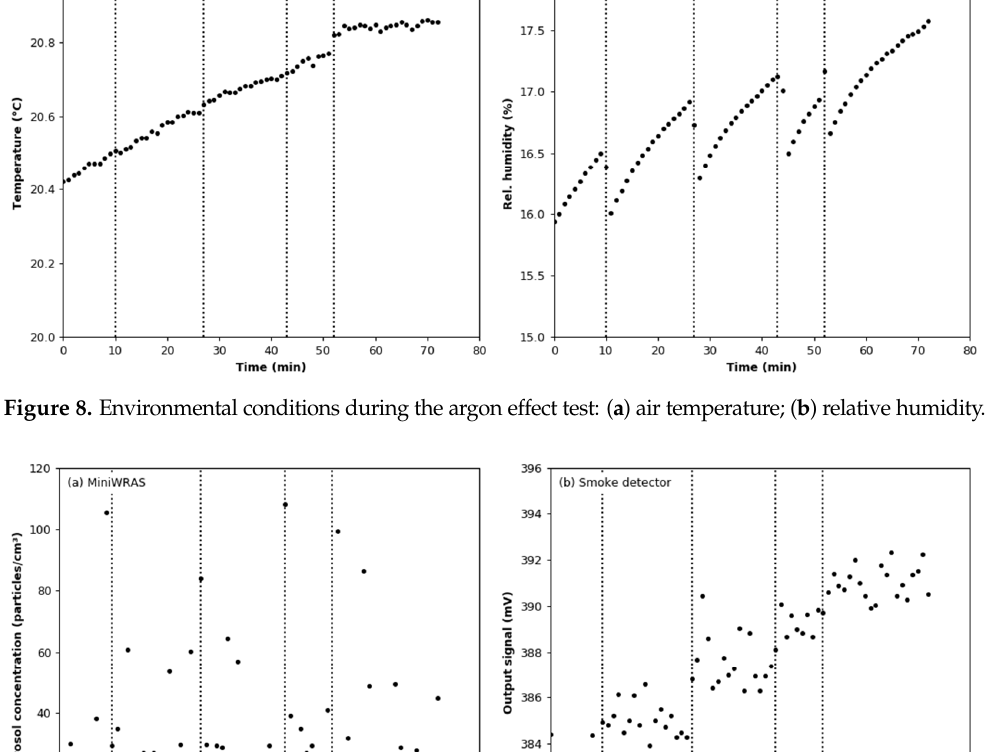
Figure 10. Environmental conditions during the soot effect test: ( a ) air temperature; ( b ) relative hu- midity.